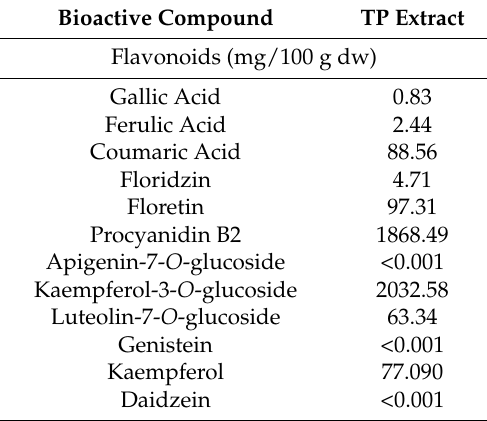
Table 1. Amounts of bioactive compounds in tomato pomace (TP)